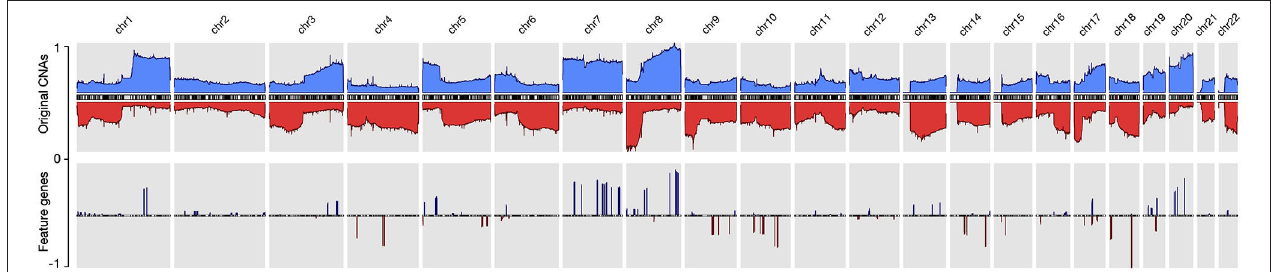
FIGURE 2 | The copy number alternation landscape of all samples using the original CNVs and the feature genes. The feature genes are able to dramatically reduce the complexity of CNA signals while maintaining the mutational characteristics. The blue colors above the chromosome axis represent the average amplifications, and the red colors below the chromosome axis represent the average deletions. The amplitude of amplifications and deletions are normalized to [0,1]